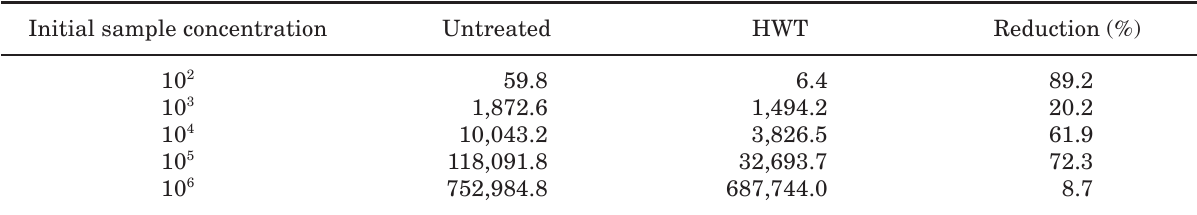
Table 7. The effect of hot water treatment on detection of P. chlamydospora spores using SYBR ® Green quantitative PCR. All data refer to No. of spores ml -1 . Initial sample